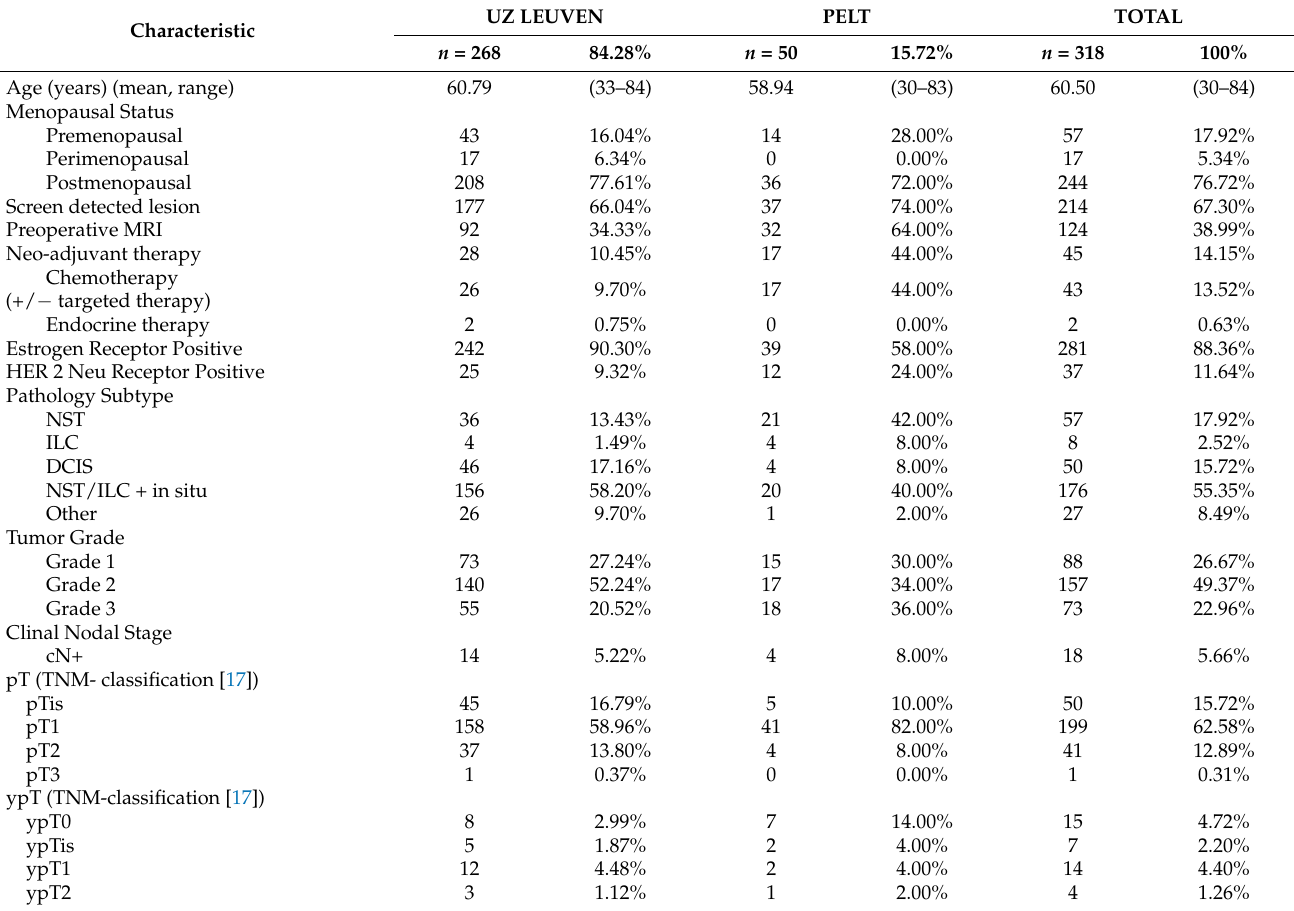
Table 1. Baseline characteristics of patients with invasive breast cancer and ductal carcinoma in situ.